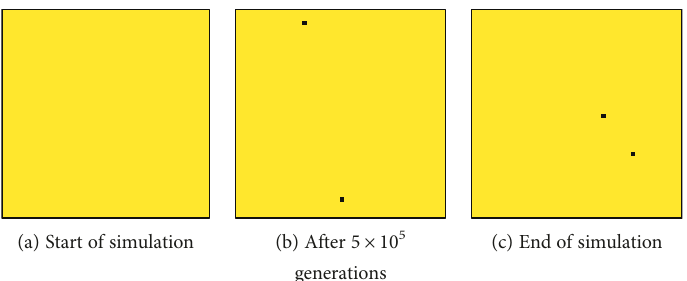
Figure 12: Illustration of a system where mutations of instantly expressed cooperator genes ( Y = C ) occur in a 50 × 50 system dominated by defector genes ( Y = D